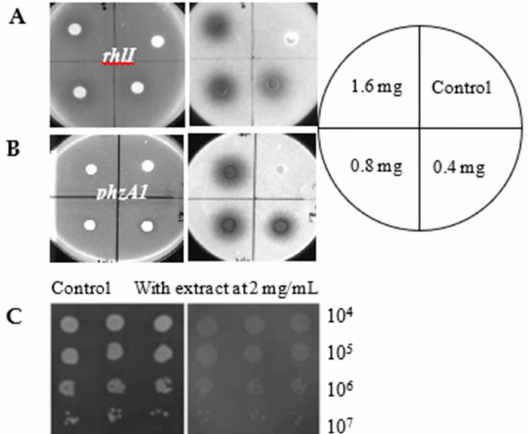
Figure 1. E ff ect of Notopterygium incisum crude extract on rhlI ( A ) and phzA1 ( B ) expression by disc di ff usion assay. Reporter strains were mixed with the Luria–Bertani (LB) agar medium (Luria–Bertani broth with 0.8% agar), and after incubation, images of the plates were captured under both white light (left) and in dark (right). In dark, inhibition of light production of the reporters is visualized as dark zones around the samples. The concentrations of crude extracts used in each spot are indicated on the right. ( C ) The growth comparison by CFU counting using drop plate method. The grayish color on the right was due to the color of the crude extract. The samples were tested in triplicate in three columns.